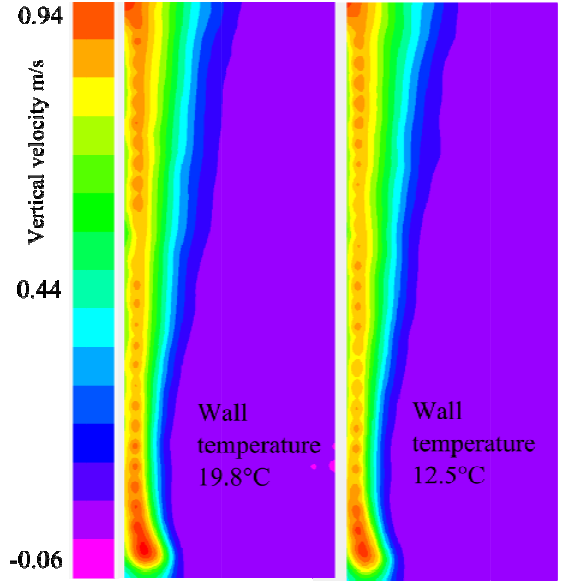
The comparison of the vertical velocity for temperature